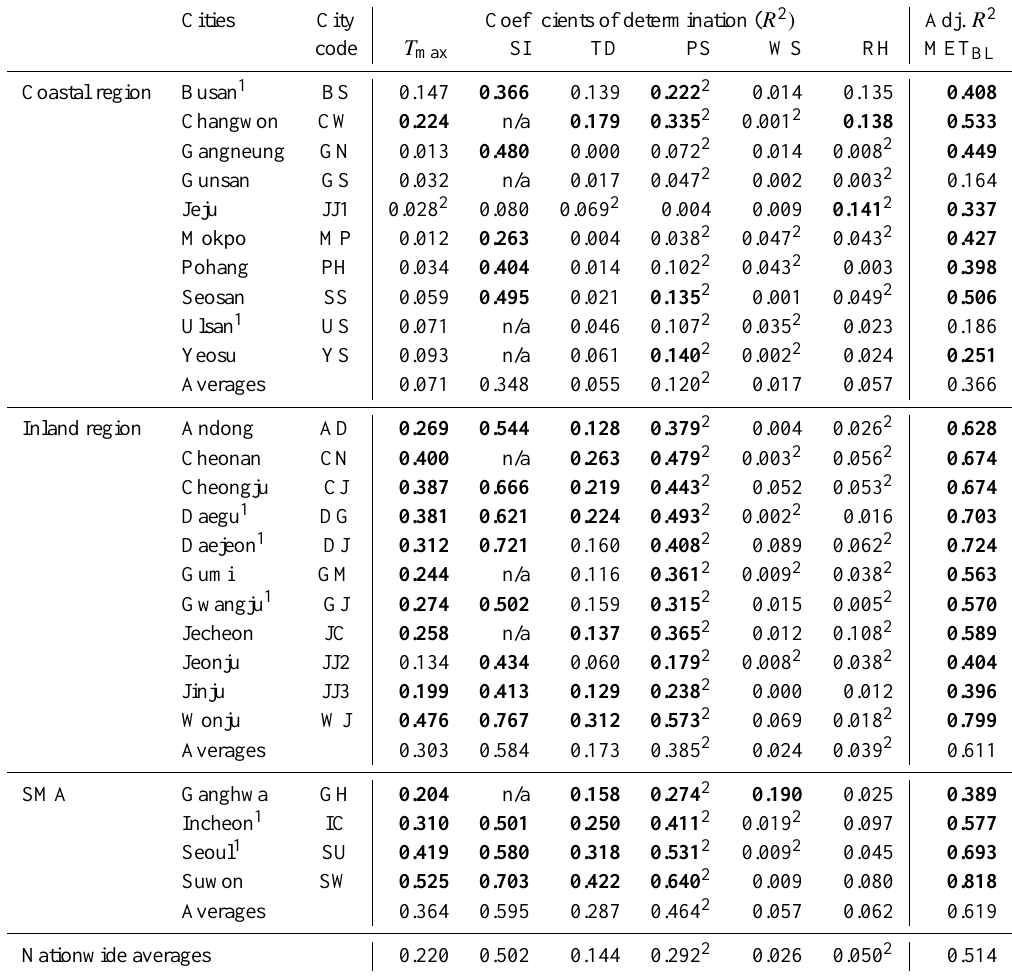
Table 2. Coefficients of determination ( R 2 ) between the baseline of daily maximum 8h average O 3 (O 38h ) and baselines of six meteorolog- ical variables ( T max , SI, TD, PS, WS, and RH) at 25 cities over South Korea for the period 1999–2010. Adjusted R 2 (Adj. R 2 ) between the baseline of O 38h and combined meteorological effects ( a 0 + P i a i MET BL (t) i ) are also represented. The cities are categorized into three groups: 10 coastal cities, 11 inland cities, and 4 cities in the SMA. Numbers in bold fonts indicate correlations significant at the 95% level or